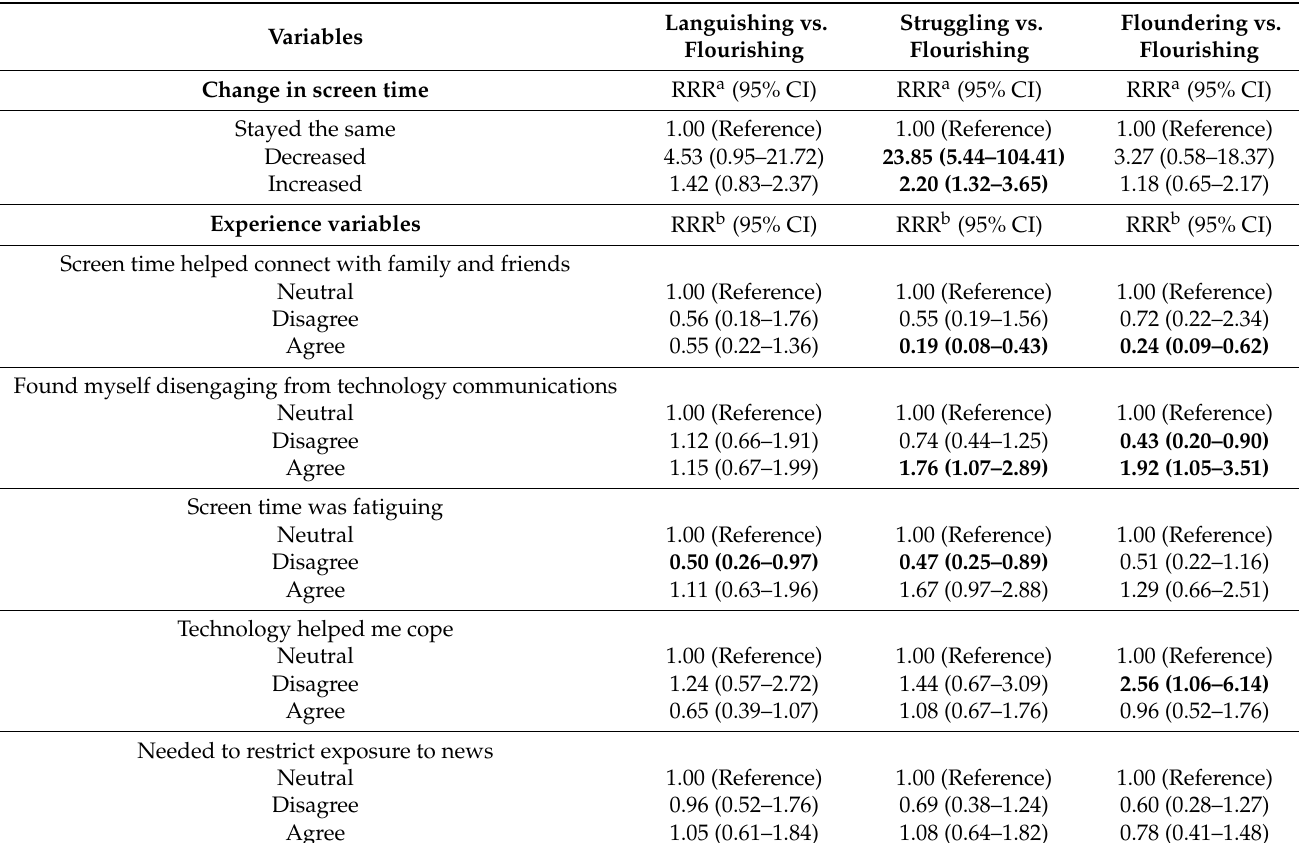
Table 4. Associations between screen time variables and mental health state during COVID-19 lockdowns/restrictions. Variables